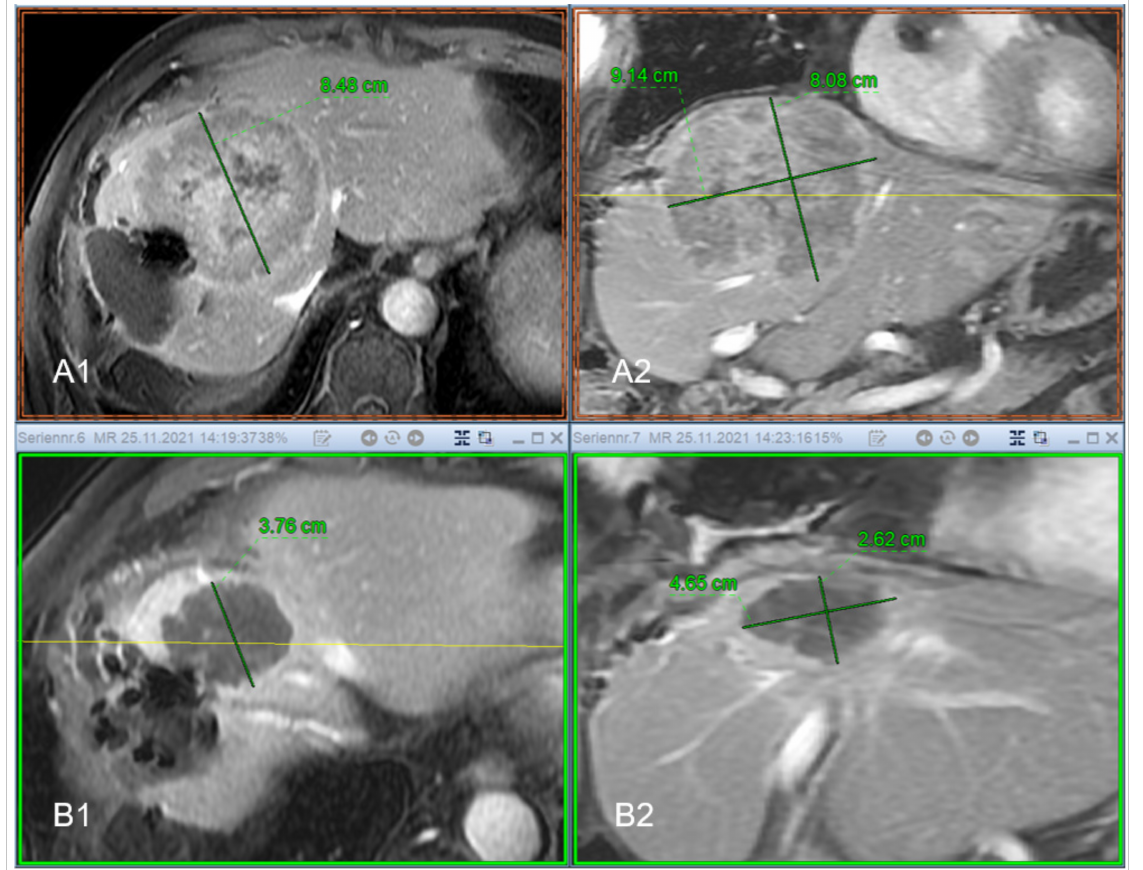
Figure 6. Seventy-three-year-old patient with previous surgery for Hepatocellular Carcinoma (HCC) and thus a significantly reduced liver reserve. The resection margin shows an extensive recurrence with the dimensions 8.48 cm × 9.14 cm × 8.08 cm (ap × lr × cc) and a volume of 313.13 cc (( A1 ) transversal contrast enhanced MRI, ( A2 ) coronal contrast enhanced MRI, respectively). After success- ful radioablation by means of interstitial brachytherapy (IBT), there is a good response to therapy. In the imaging follow-up after 9 months, the lesion is completely necrotic, shows no signs of vitality and shrinks in time to 3.76 cm × 4.65 cm × 2.62 cm, which corresponds to a volume of 22.9 cc (( B1 ) transversal contrast enhanced MRI, ( B2 ) coronal contrast enhanced MRI, respectively). Formally, the course of the findings is to be evaluated as a complete remission